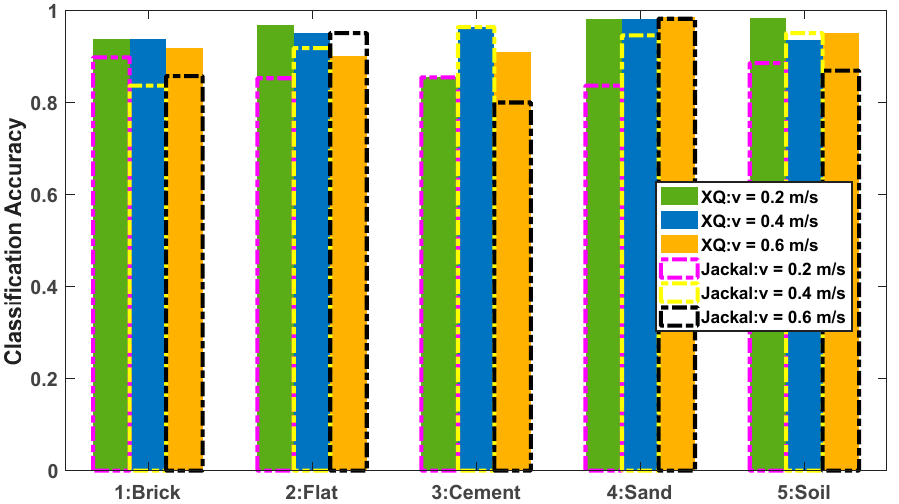
Figure 13. Accuracy comparison of different platforms at different speeds.